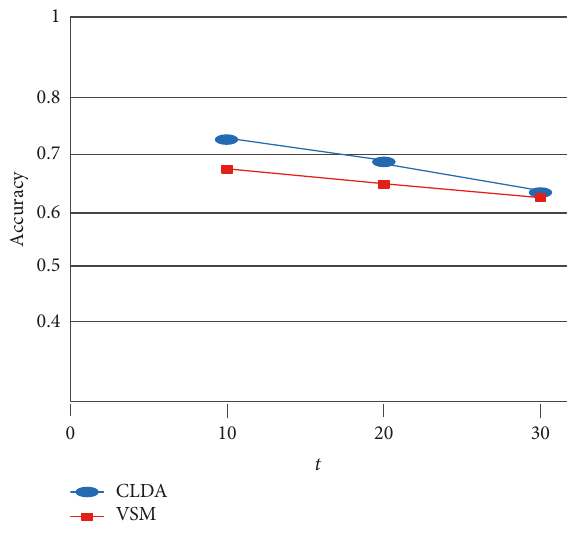
Figure 6: Recommended accuracy in entertainment field.